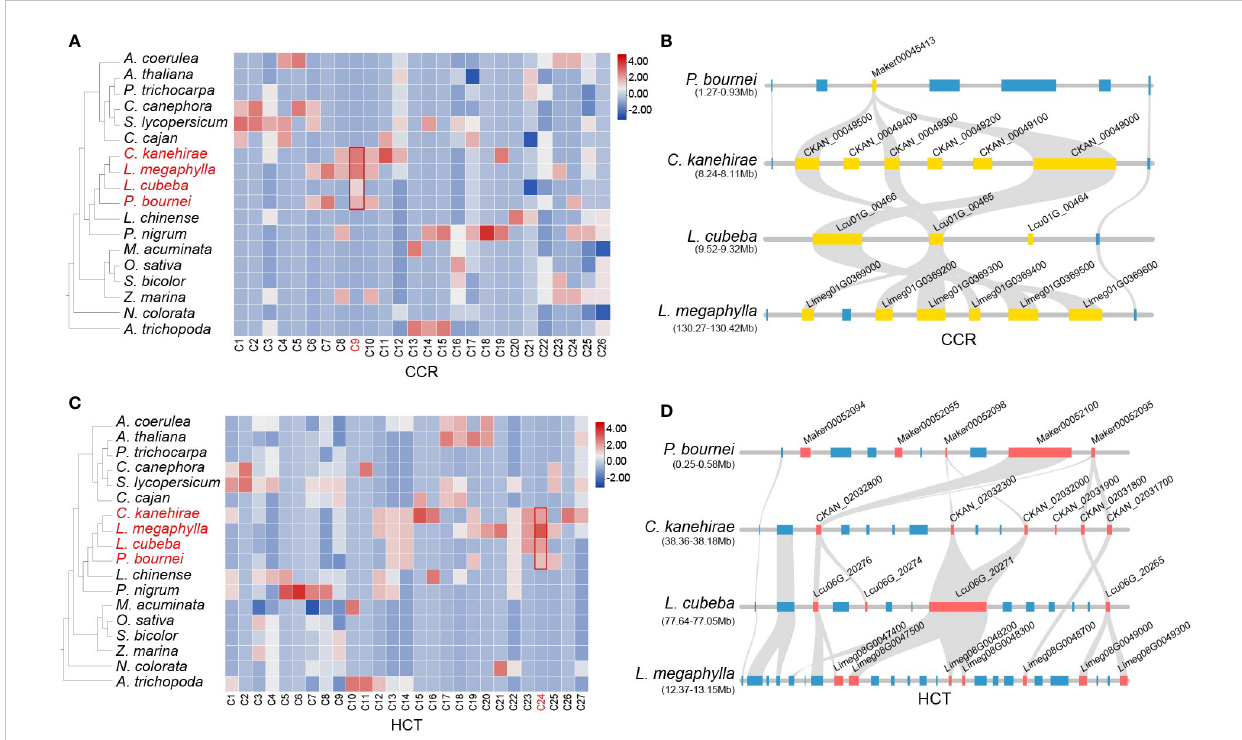
FIGURE 8 Lauraceae-speci fi c CCR and HCT genes in lignin biosynthesis pathway. (A) Heatmap of 26 microsynteny clusters identi fi ed to be related with CCR gene family, one of which speci fi c to Lauraceae were highlighted in a red square. Color in the heatmap was determined by the gene number found in each cluster for each species. (B) The syntenic block containing of CCR gene family within the Lauraceae-speci fi c microsynteny gene cluster (C9) identi fi ed in (A) . Here this syntenic block was compared among P. bournei , C. kanehirae , L. cubeba and L. megaphylla . Yellow squares represent the CCR genes and blue ones represent other genes on the syntenic block. (C) Heatmap of 27 microsynteny clusters identi fi ed to be related with HCT gene familiy, one of which speci fi c to Lauraceae were highlighted in a red square. Color in the heatmap was determined by the gene number found in each cluster for each species. (D) The syntenic block containing of HCT gene family inside the Lauraceae-speci fi c microsynteny gene cluster (C24) in (C) . Here this syntenic block was compared among P. bournei , C. kanehirae , L. cubeba and L. megaphylla . Red squares represents the HCT genes and blue ones represents other genes on the syntenic